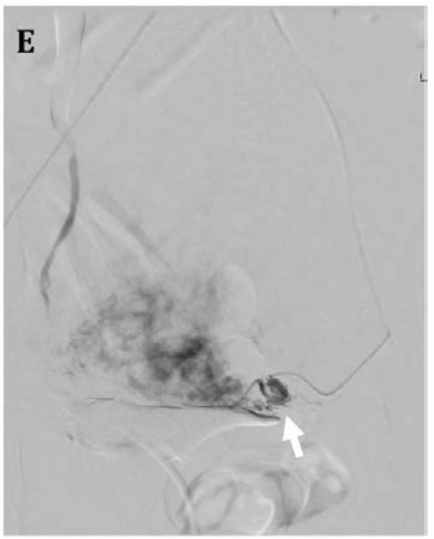
Figure 3. Thirty-five-year-old female with placenta percreta. ( A ) Ultrasound at 19 weeks of gestation shows an abnormal placenta with multiple placental sonolucencies and focal bulging of placental tissue into the bladder (arrow). ( B ) Sagittal FIESTA MR image shows no discernable fat plane between placental tissue and bladder serosa (arrowhead), suspicious for bladder wall